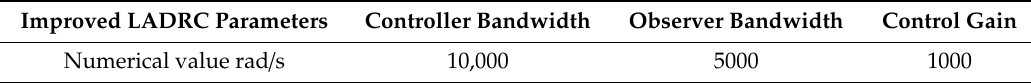
Table A2. Improved LADRC